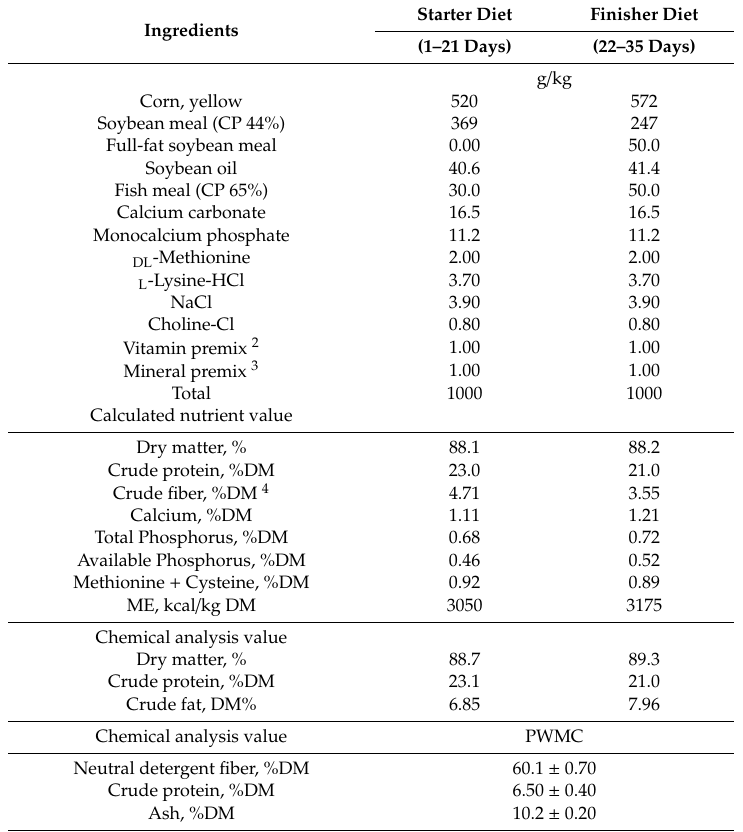
Table 1. Composition and calculated analysis (g / kg as fed) of the basal diet for broilers (1–35 days) 1 .